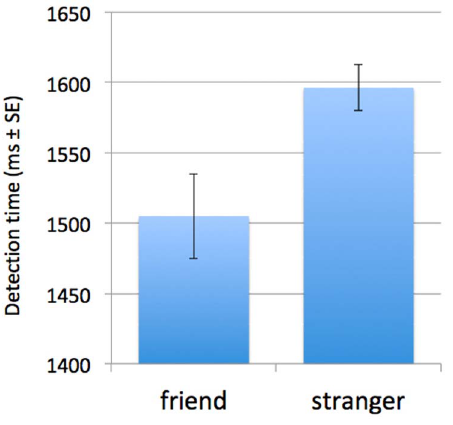
Figure 4. Results of the CSF experiment. Faces of friends were detected 91 6 40 SE ms faster than were faces of